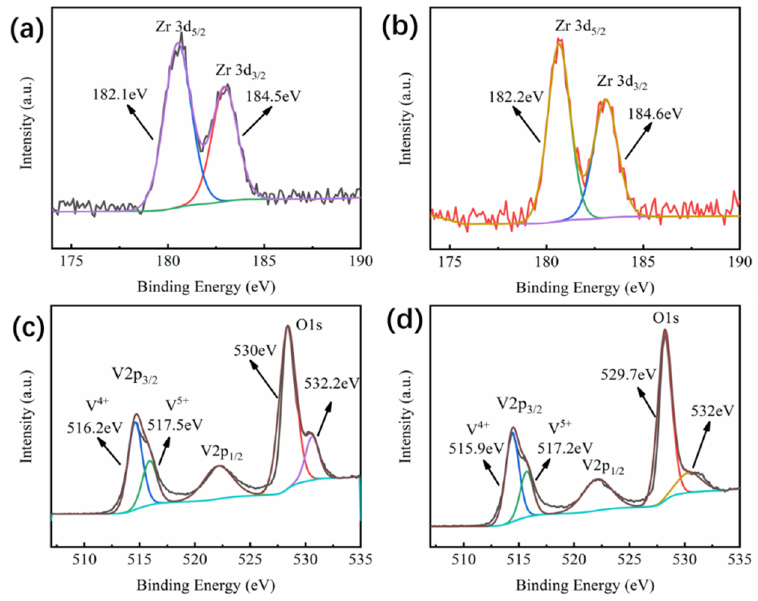
Figure 7. High-resolution XPS spectra for Zr 3d in ( a ) sample ZrO 2 -90 W and ( b ) sample ZrO 2 -90 W-acid, and V 2p and O 1s core levels in ( c ) sample ZrO 2 -90 W and ( d ) sample ZrO 2 -90 W-acid.